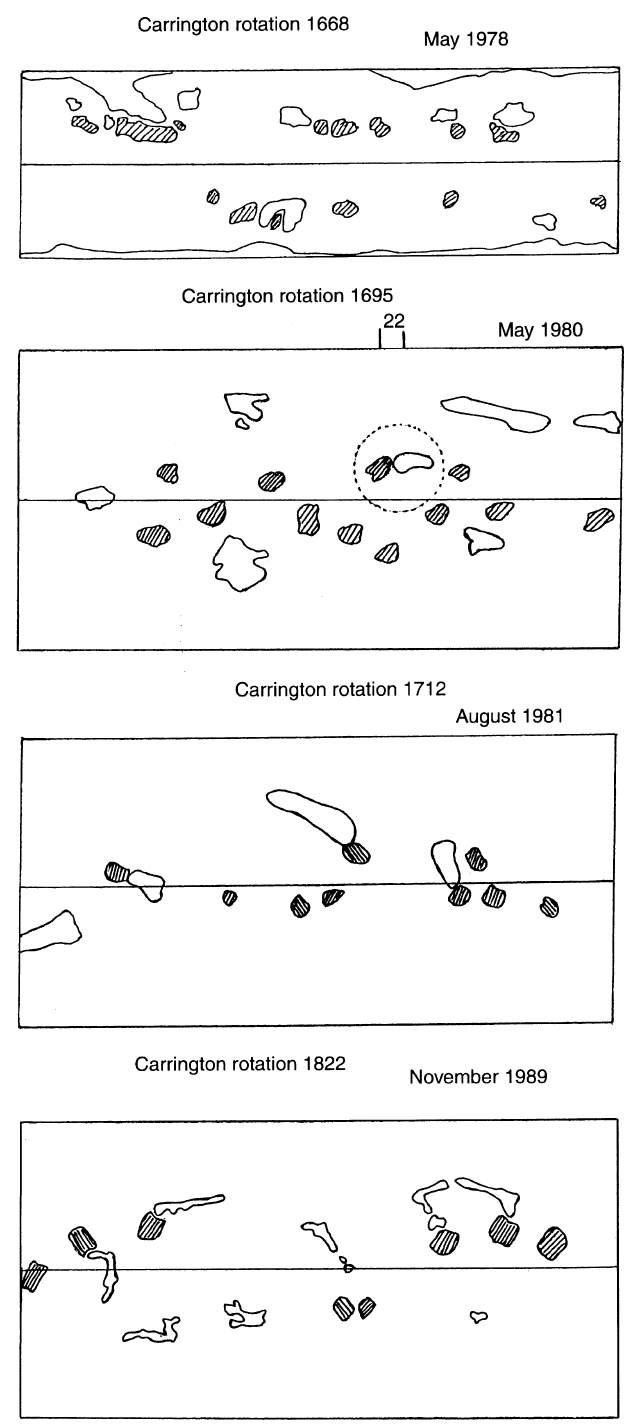
Fig. 5. Carrington rotation maps 1668 (May 1978), 1695 (May 1980), and 1712 (August 1981), corresponding to the sunspot maximum of cycle 21, and 1822 (November 1989), corresponding to the sunspot maximum of cycle 22, showing the corresponding coronal holes ( white ) and active regions ( dashed ). The circle in the Carrington rotation 1695 indicates the source region of the interplanetary disturbance that caused the 25 May IGS. The position of the solar central meridian at the day of the solar event is indicated at the top of the